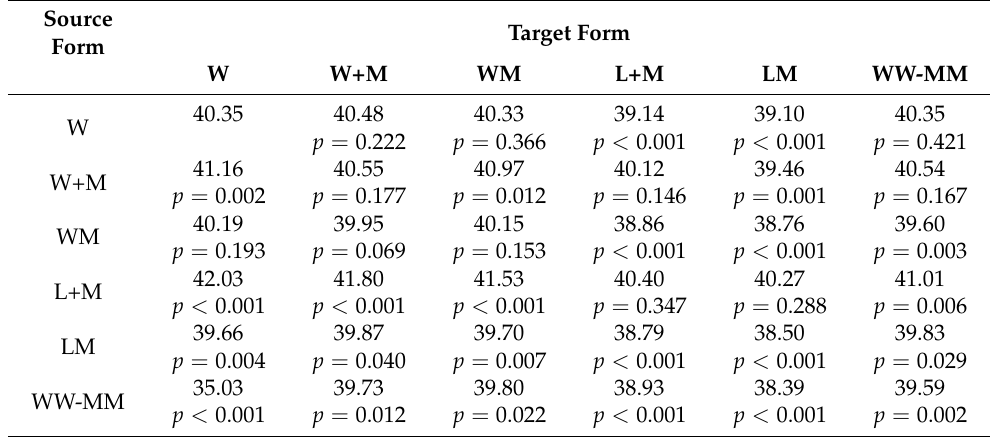
Table 9. BLEU scores and p -values for the translations from Slovene to English for different systems on the Europarl